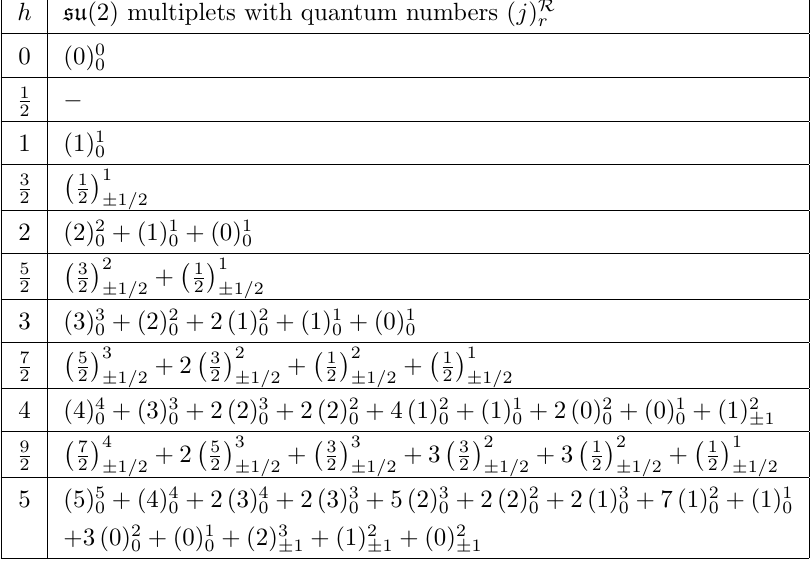
encodes the spin j r (cid:0) 1 (cid:1) 1 , we mean that multiplets with r = 1 = 2 2 (cid:6) 1 = 2